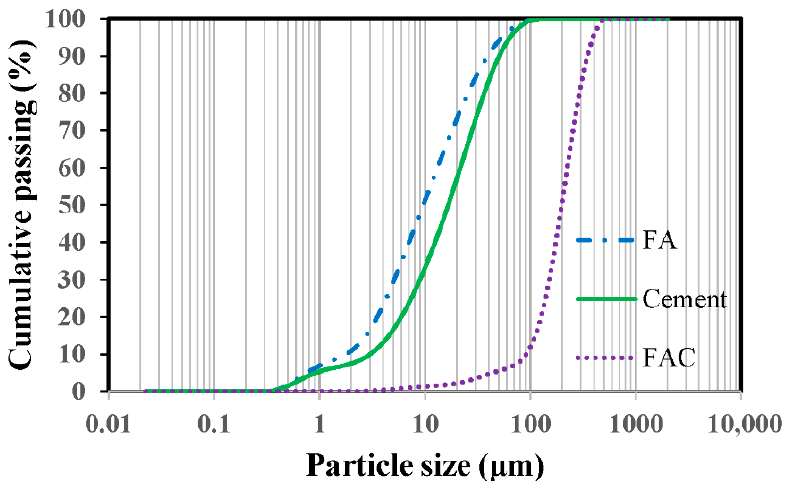
Figure 1. Particle size distributions of main raw materials. Table 2. Physical and mechanical performances of PE fibers.